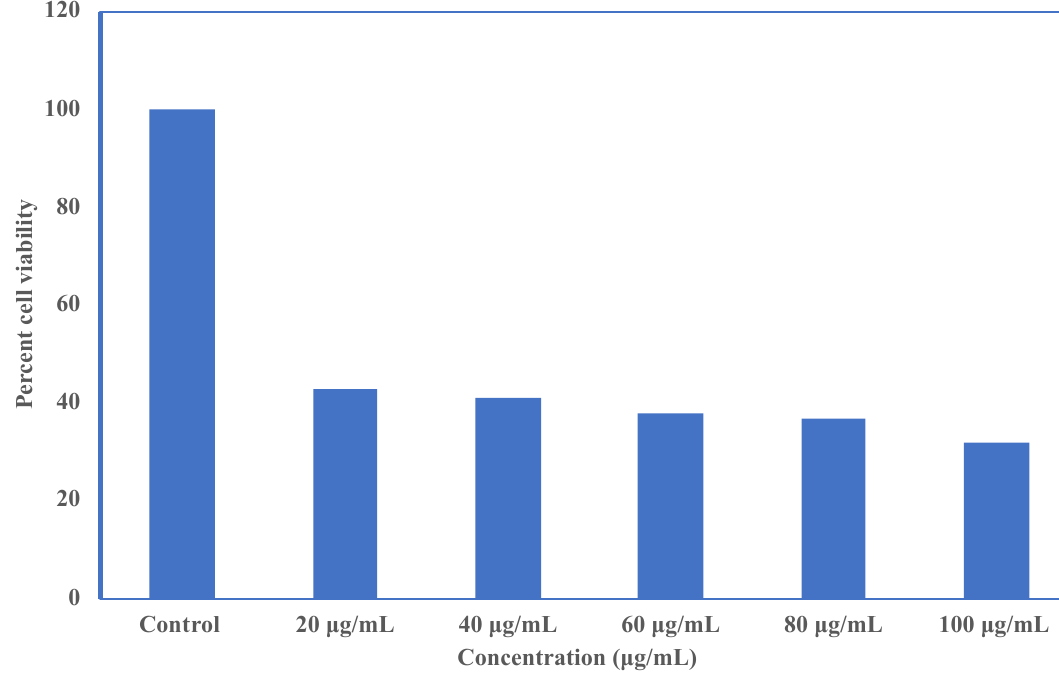
Figure 6. In vitro cytotoxicity and percent cell viability assay against MCF-7 breast cancer cell lines. Nanomaterials 2020 , 10 , x FOR PEER REVIEW